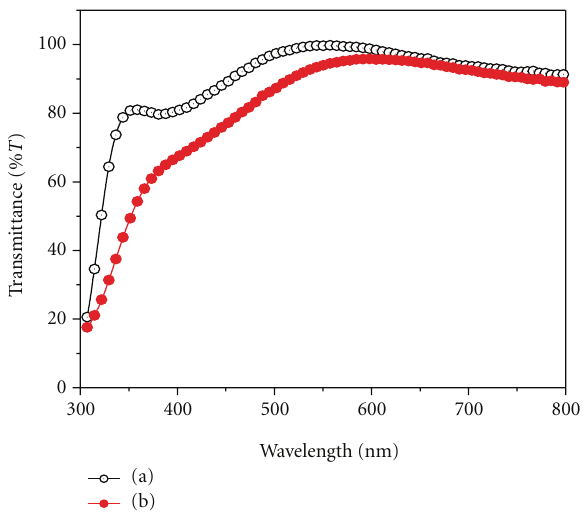
Figure 5: Current density ( J )-voltage ( V ) characteristics of solar cells on commercial ITO and RF sputtered ITO thin